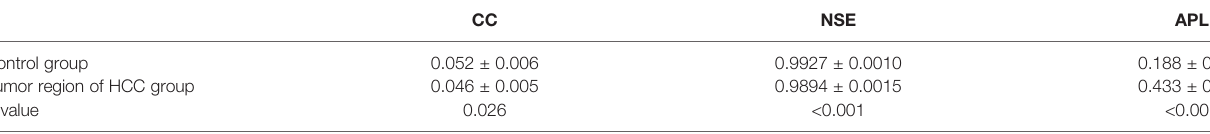
TABLE 1 | Comparison of vascular network connectivity of tumor region of HCC group and normal control group.